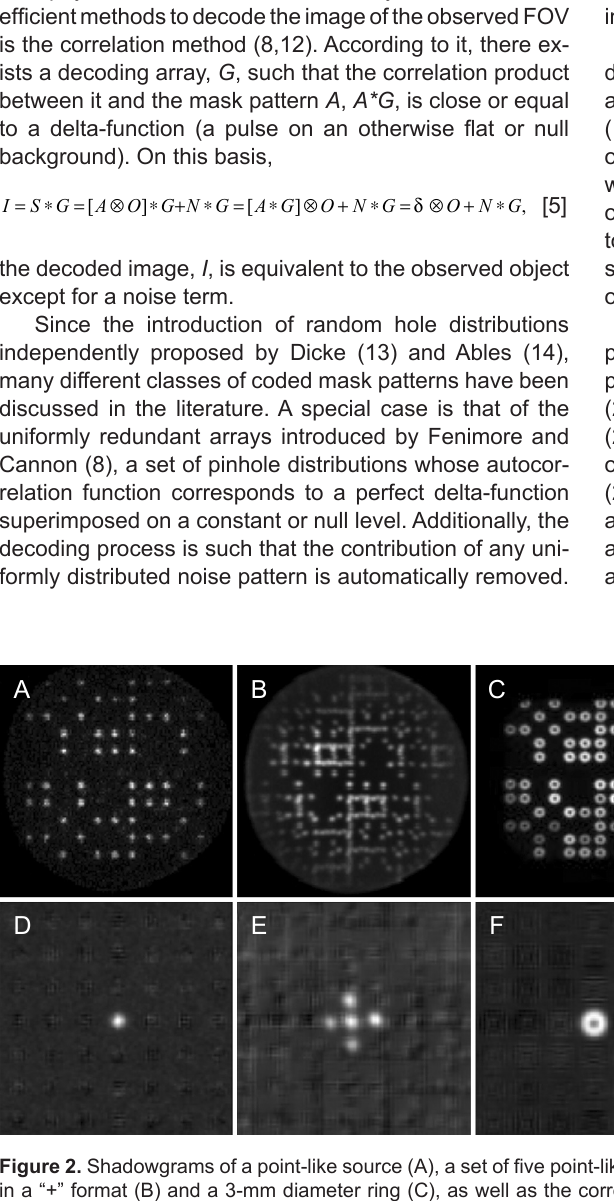
Figure 2. Shadowgrams of a point-like source (A), a set of five point-like sources in a “+” format (B) and a 3-mm diameter ring (C), as well as the corresponding decoded images (D, E, F). The images were obtained with a Siemens-Orbiter gamma-camera in combination with a 7 x 7-MURA coded mask collimator, and pixellated on 128 x 128 element arrays. Decoding was done using the correlation method. Objects were located 50 mm from the collimator and the magnification factor was 4. For the point-like source, a resolution of 3.55 mm (full-width at half- maximum) was obtained.